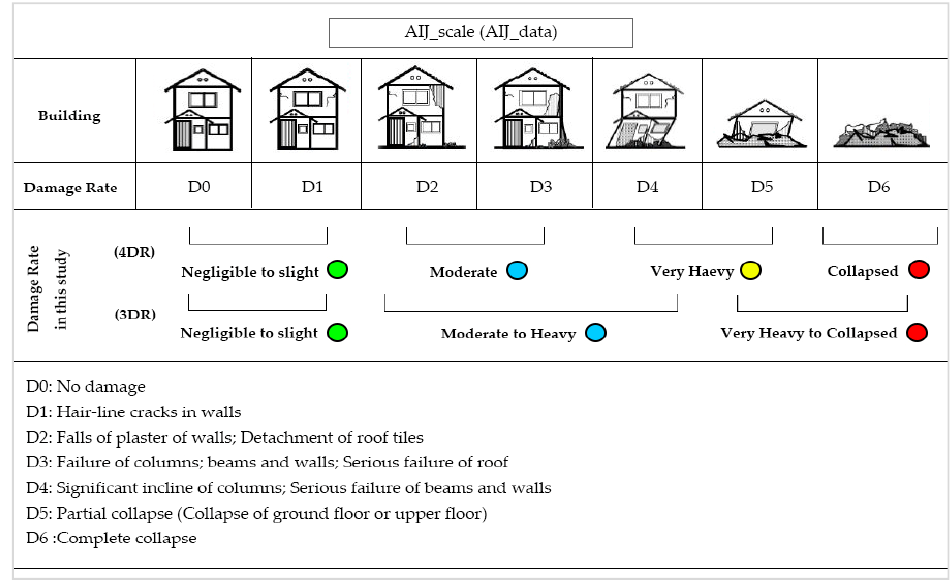
Figure 8. The Architectural Institute of Japan scale (AIJ) [15,33].